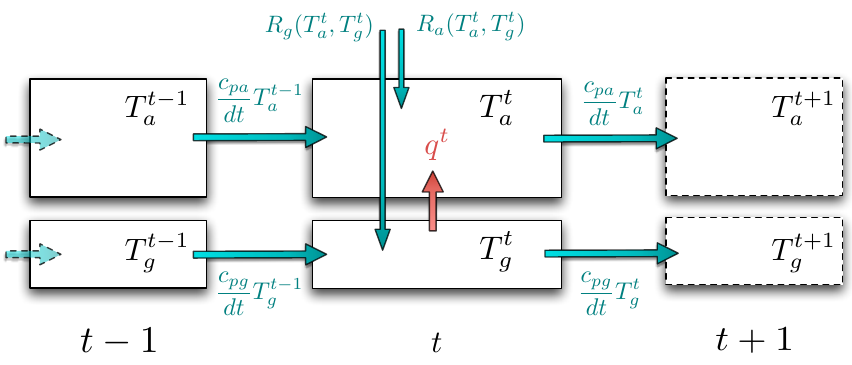
Fig. 10. To discuss the stability of the steady states predicted by MEP, we need to extend the principle to obtain a time-dependent formulation. This is done by maximizing the instantaneous entropy production rate. To compute the time derivative of the temperature, we consider it as a known flux in time seen as a geometric dimension of the space upon which MEP operates (see text). In green, the fluxes that can be computed from the state variables (T t − 1 a , T t a , T t − 1 g , T t g ) . In red, the unknown flux obeying MEP.